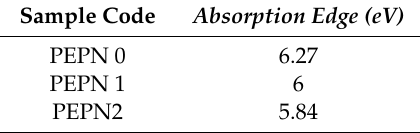
Figure 6. The variation of absorption coefficient as a function of photon energy for the pure PEO and PEO composite samples at room temperature. Table 1. Absorption edge values for pure PEO (PEPN0), PEO:CNDs (PEPN1), and PEO:CNDs:Ag (PEPN2) composite samples.